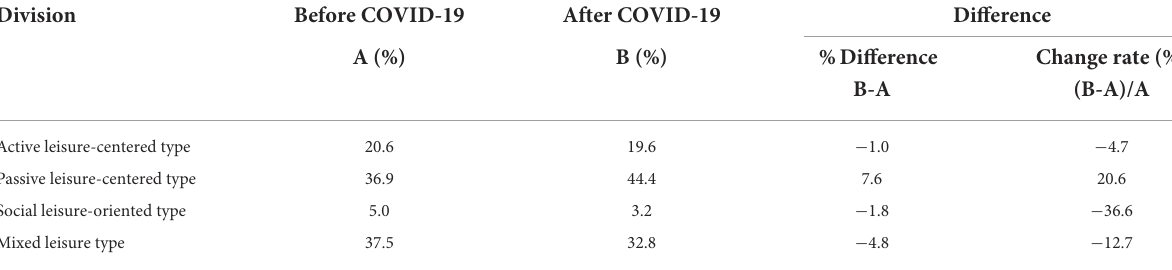
TABLE 3 Changes in leisure activities of the elderly after COVID-19: aspects of leisure activities.